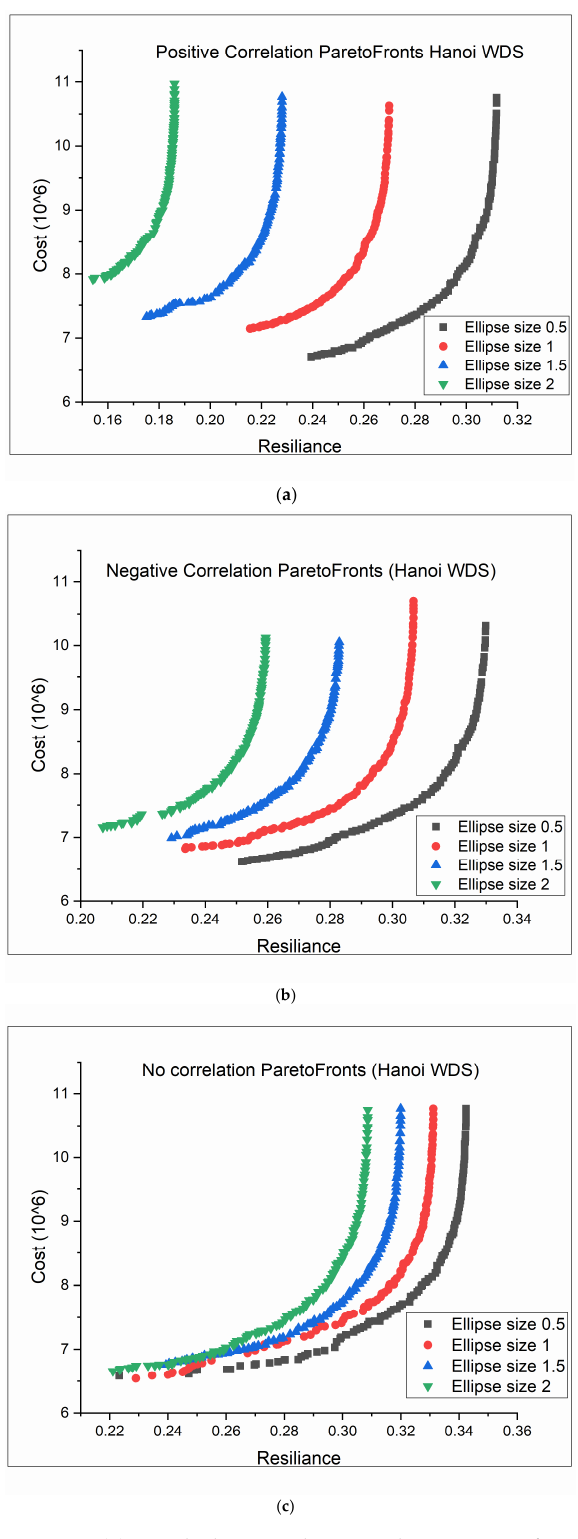
Figure 3. ( a ) Graph showing the WDS design Pareto fronts for Hanoi WDS with demand variation with positive correlation; ( b ) graph showing the WDS design Pareto fronts for Hanoi WDS with demand variation with negative correlation; ( c ) graph showing the WDS design Pareto fronts for Hanoi WDS with demand variation with no correlation.